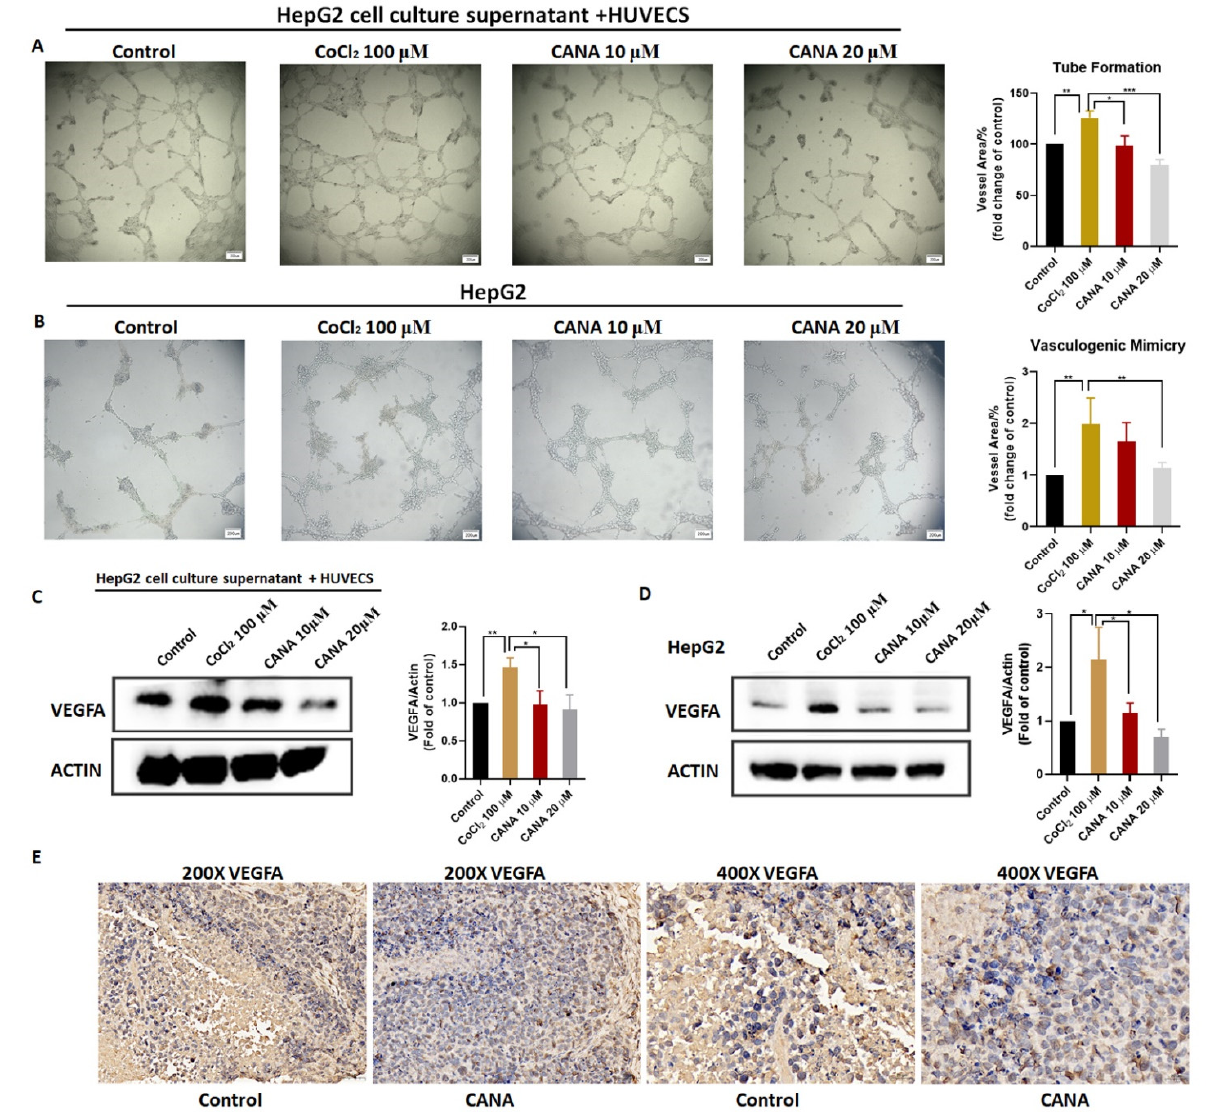
Figure 3. CANA inhibited hypoxia-induced angiogenesis. HepG2 cells were cultured in DMEM medium or CoCl 2 100 μ M and CANA (10 or 20 μ M) for 24 h to obtain the condition medium. ( A ) Tube formation was performed with condition medium to determine the angiogenic ability of HUVECs (50X). ( B ) Tube-like structure formation on Matrigel in HepG2 cells (50X). Protein expression levels in ( C ) HUVEC cells with condition medium or in ( D ) HepG2 cells. ( E ) Immunohistochemical staining for the VEGFA protein in tumor specimens from xenografts (200X, 400X). Data were shown as means ± S.D. ( n = 3); * p < 0.05, ** p < 0.01, and *** p < 0.001. Control, normal untreated control; CANA, CANA-treated CoCl 2 (100 μ M)-induced group.